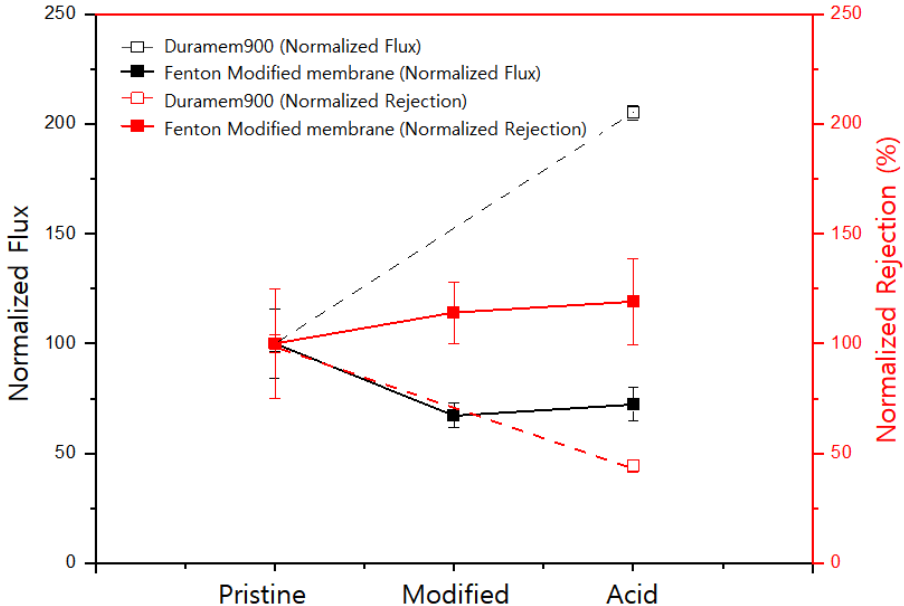
Figure 3. Normalized flux and normalized rejection of pristine and Fenton-modified PI membranes. The membrane was modified by the Fenton reaction for 1 h.